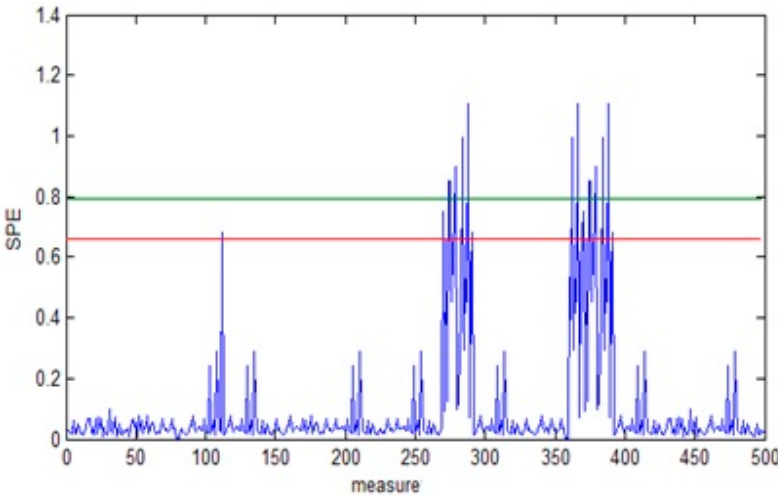
Figure 10. Fault detection and isolation using the proposed approach.